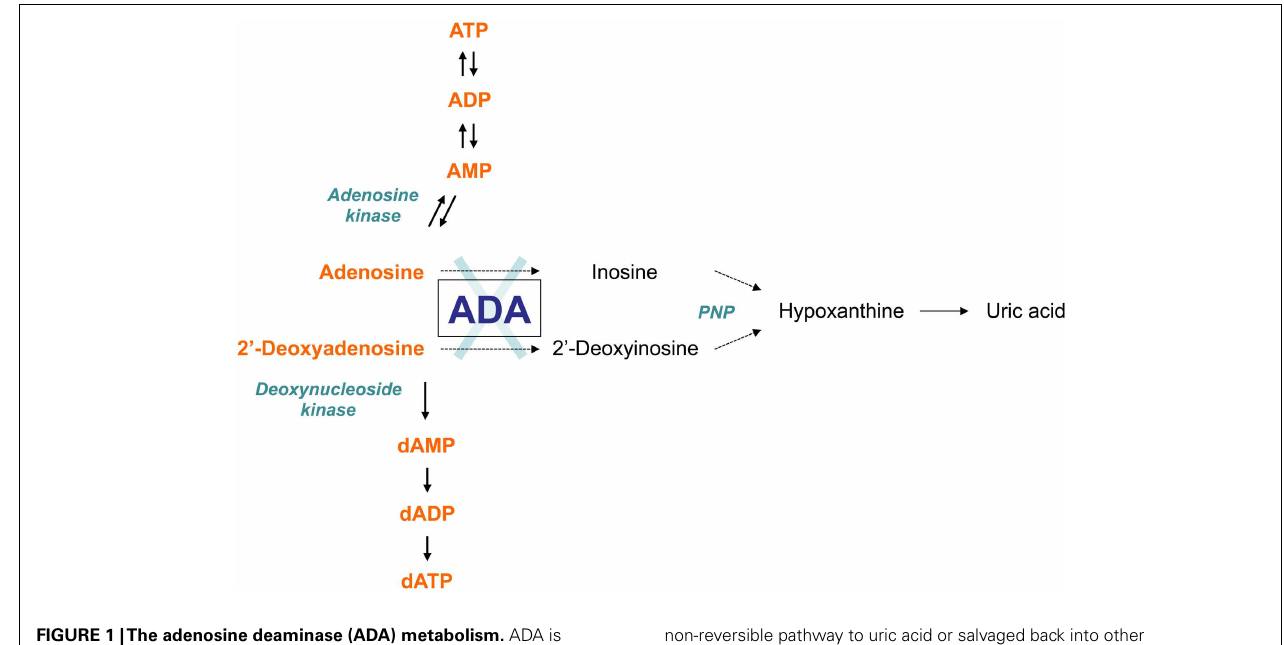
FIGURE 1 |The adenosine deaminase (ADA) metabolism. ADA is an enzyme of the purine salvage pathway, which catalyzes the irreversible deamination of adenosine and 2 (cid:48) -deoxyadenosine into inosine and 2 (cid:48) -deoxyinosine, respectively. Most adenosine derives from endogenous breakdown of ATP and degradation of RNA, or is taken up exogenously by ubiquitously expressed nucleoside transporters. Unlike adenosine, 2 (cid:48) -deoxyadenosine is formed by DNA degradation is predominantly catabolized by ADA. Further conversion of inosine nucleoside leads to hypoxanthine, which can either enter a